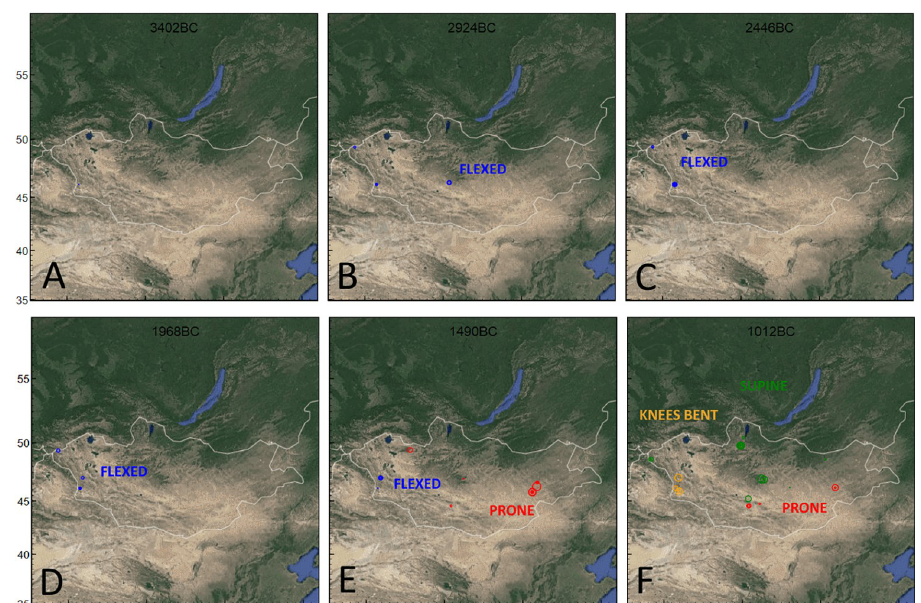
Fig 6. Posterior probability estimates for modeled dates according to burial position. For each box, the width of each circle corresponds to the portion of modeled posterior distribution that falls within the timeslice.